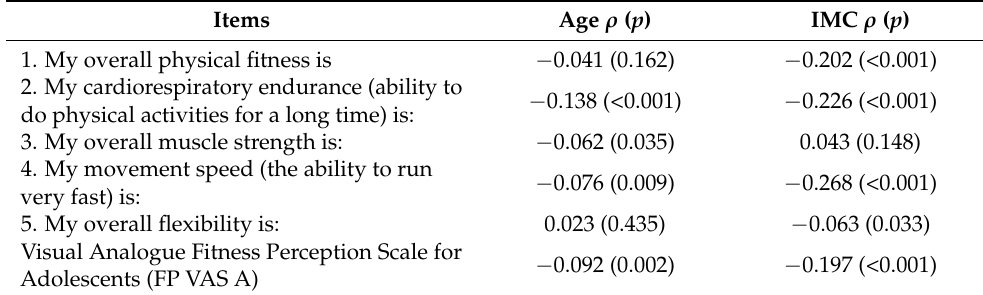
Table 3. Correlation between FP VAS A scale items with age and BMI.